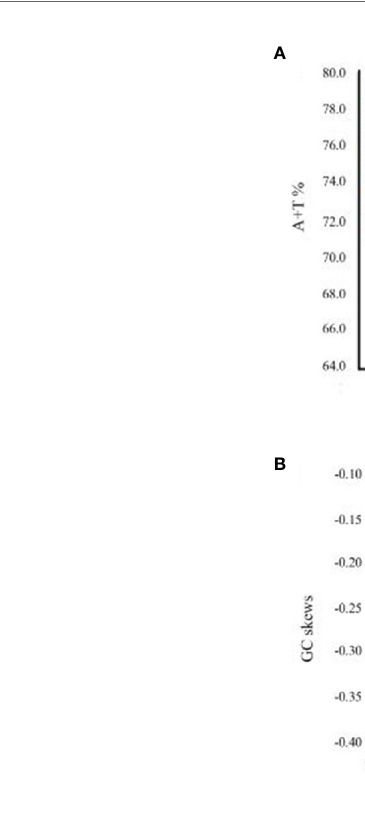
FIGURE 2 | (A) Genome size versus A+T content of the thoracotreme mitogenomes. The yellow dots represented the families Macrophthalmidae, Xenophthalmidae, Varunidae, and Pinnotheridae. The purple dots represented the families Cryptochiridae, Camptandriidae, Xenograpsidae, Dotillidae, Mictyridae, Ocypodidae, Grapsidae, Gecarcinidae, Sesarmidae, Plagusiidae, and Varunidae. The yellow dots 1 (15,107 bp) and 2 (17,226 bp) represented Chasmagnathus convexus from Varunidae and Macrophthalmus paci fi cus from Macrophthalmidae, respectively, which were the outliers. (B) AT-skew versus GC-skew in the thoracotreme mitogenomes. Ocypodoidea, Grapsoidea, Cryptochiroidea, and Pinnotheroidea were represented by blue, red, yellow, and green dots,